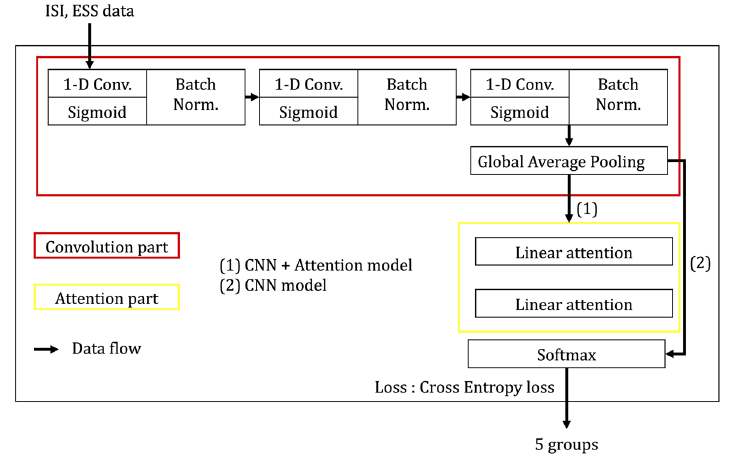
Figure 5. 1-D CNN with attention model.